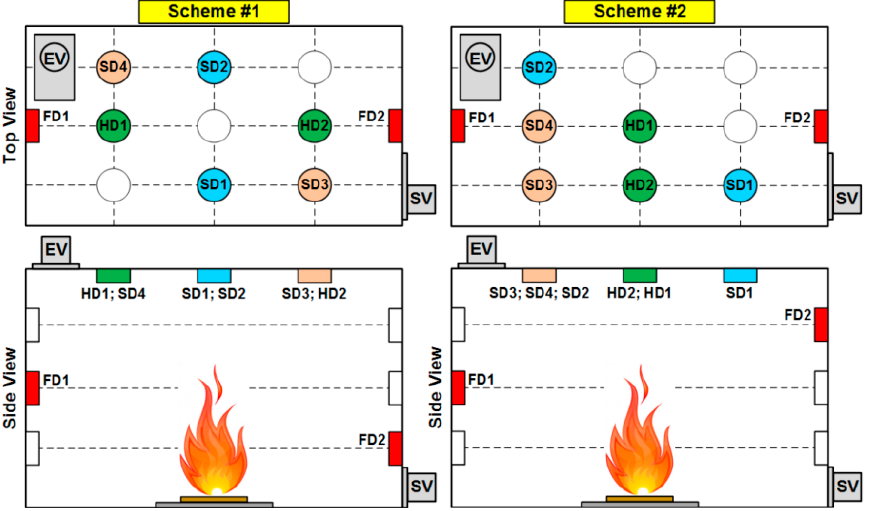
Figure 10. Schemes of fire detector arrangement in the SC.